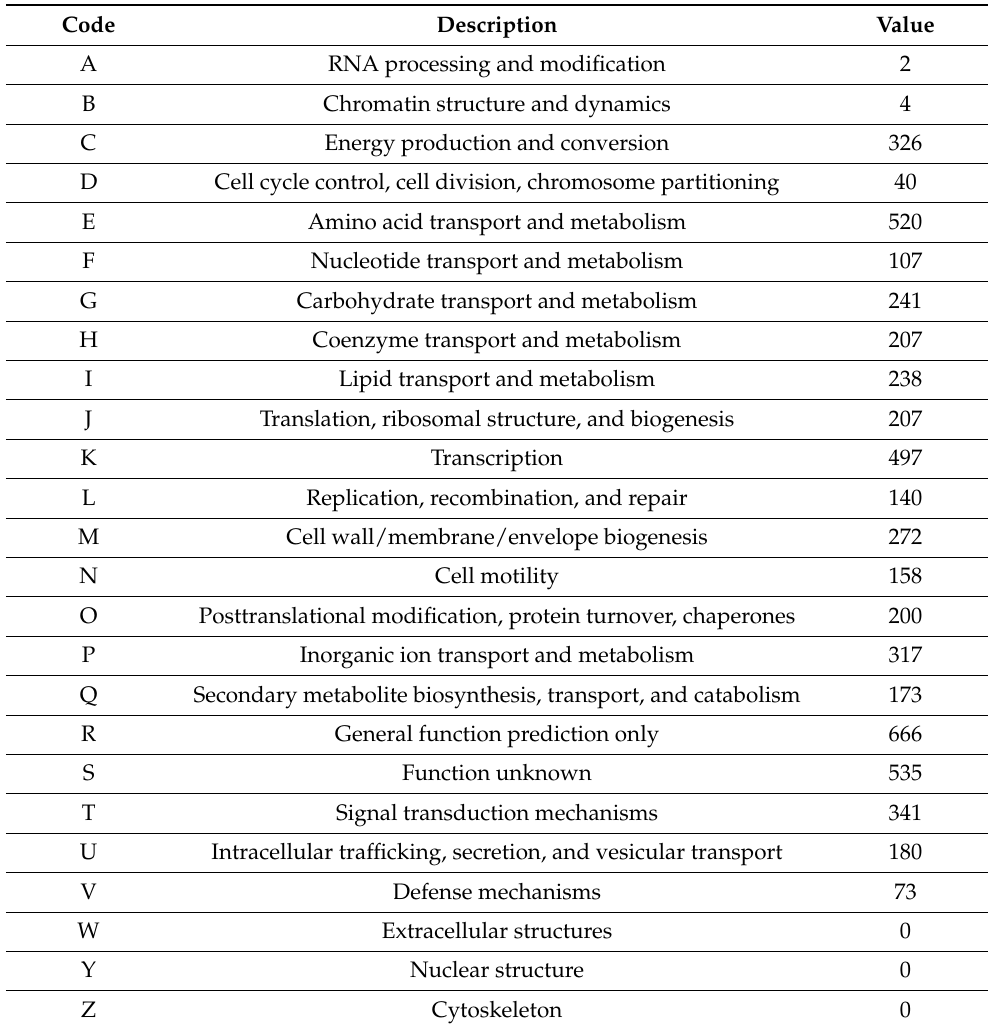
Table 7. Functional group classification based on COG analysis. Several genes associated with COG functional categories were